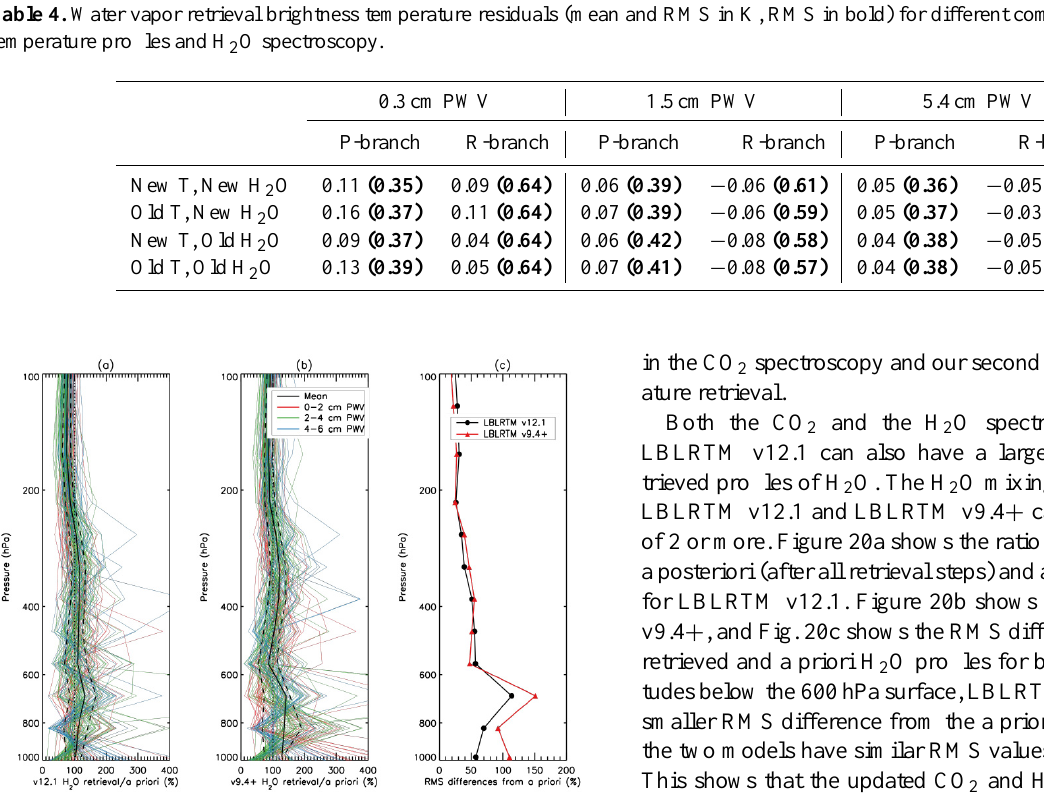
Fig. 20. (a) Ratio of the final a posteriori (retrieved) H 2 O profile using LBLRTM v12.1 to the a priori temperature profiles, as a per- cent. The thin red, green, and blue lines are the differences for the individual scans, and correspond to a PWV of 0–2, 2–4, and 4–6cm, respectively. The thick black line shows the mean ratio to the a priori over all 120 scans, with the black dashed lines showing the 25th and 75th percentiles. (b) As in (a) , but for LBLRTM v9.4 + . (c) RMS of the percentage differences between the a posteriori and a priori H 2 O profiles for v12.1 (black circles) and v9.4 + (red